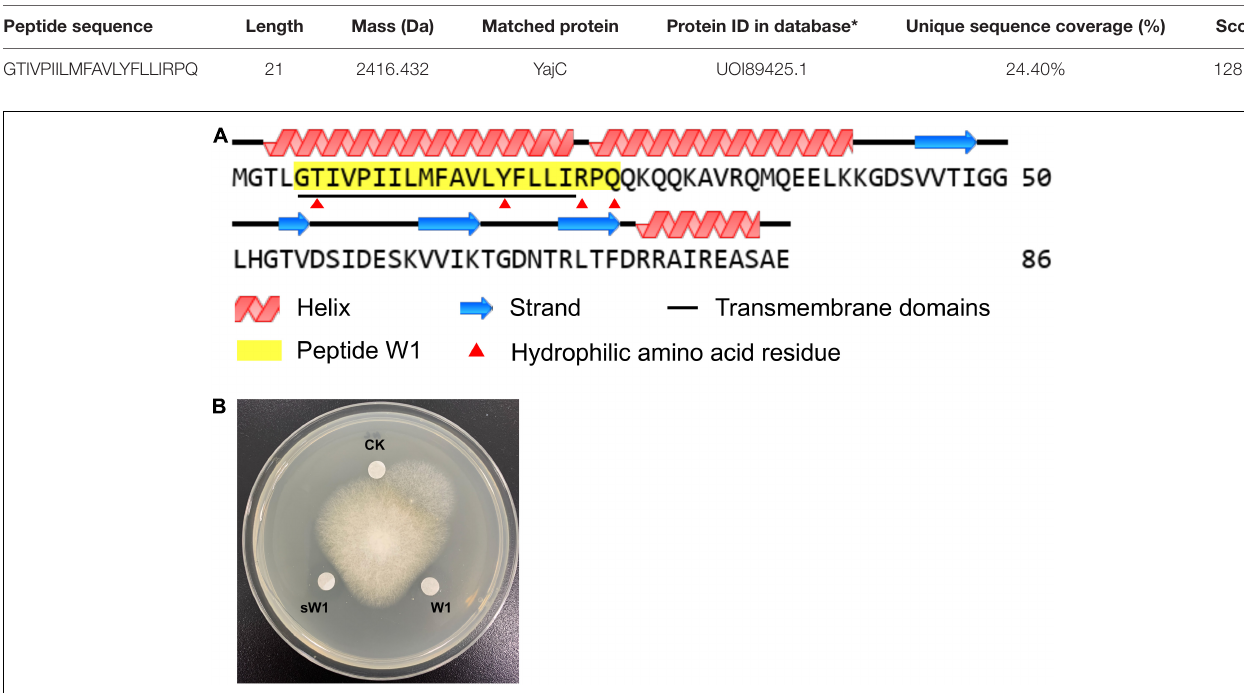
TABLE 2 | Mass spectrum identification of W1.